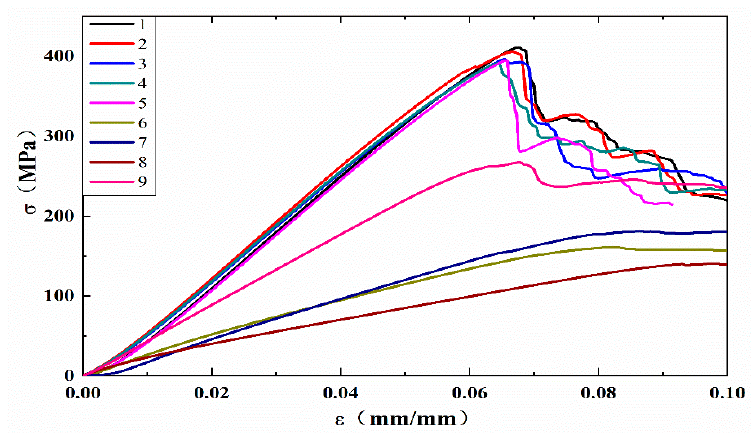
Figure 15. The σ - ε curve for the static loading.